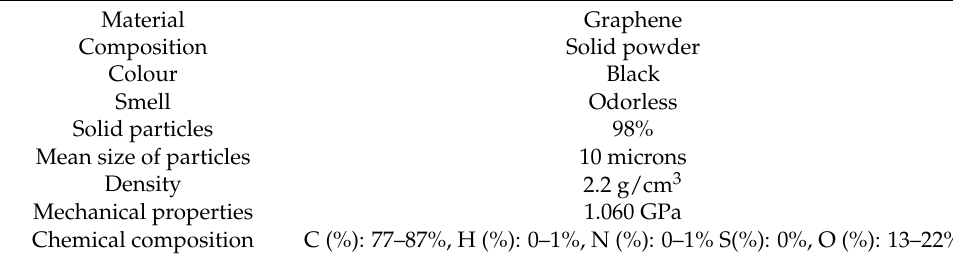
Table 2. Specifications of powder graphene (Source: LucasLed Smart Saving)